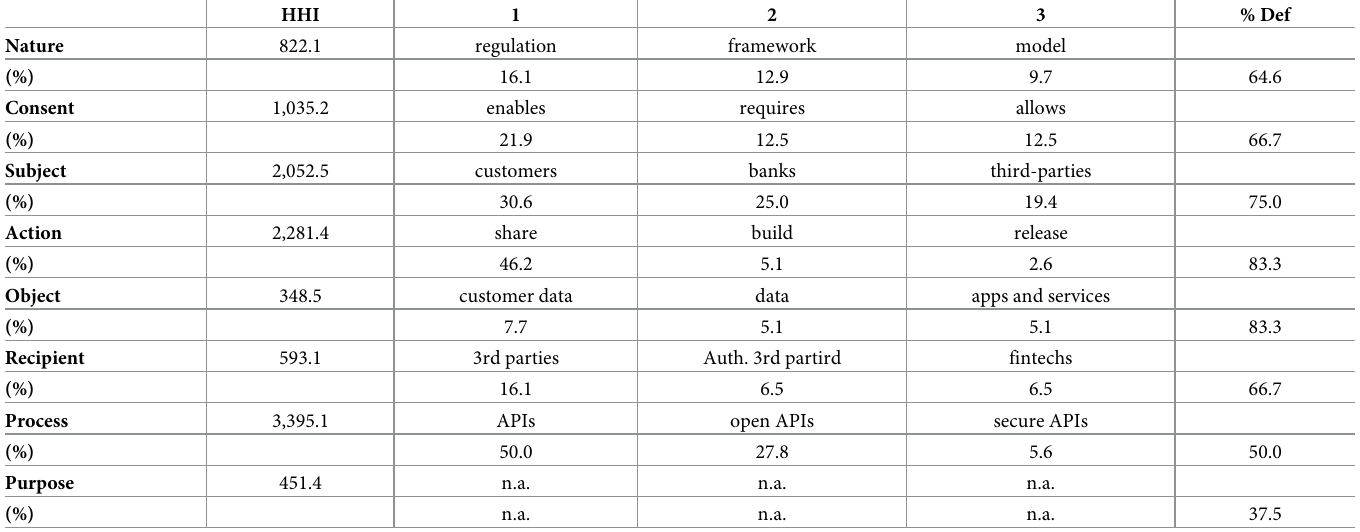
Table 2. Summary of definitions’ descriptive